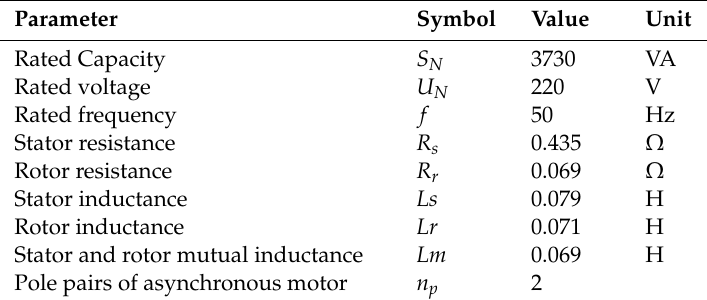
Table A1. Three-phase cage asynchronous motor